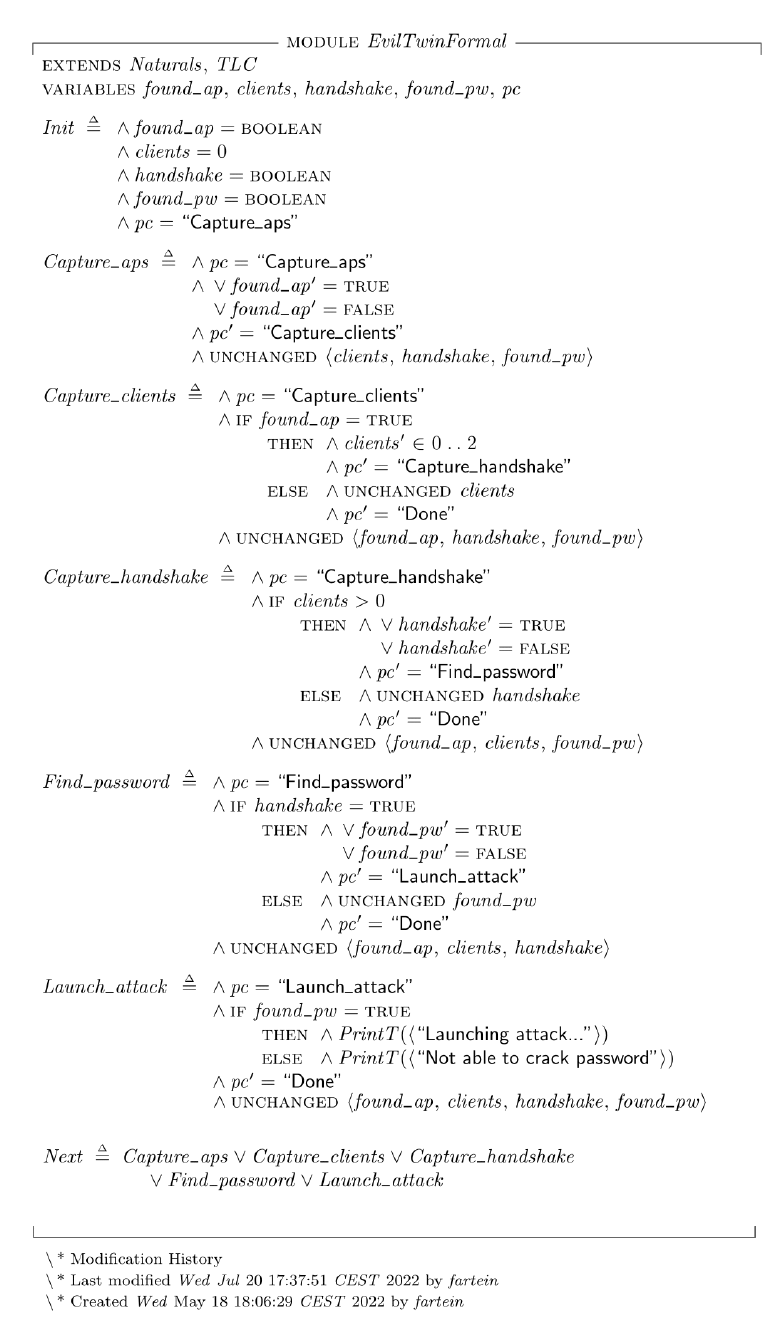
Figure 18. The formal specification of the Evil Twin attack EP model written in